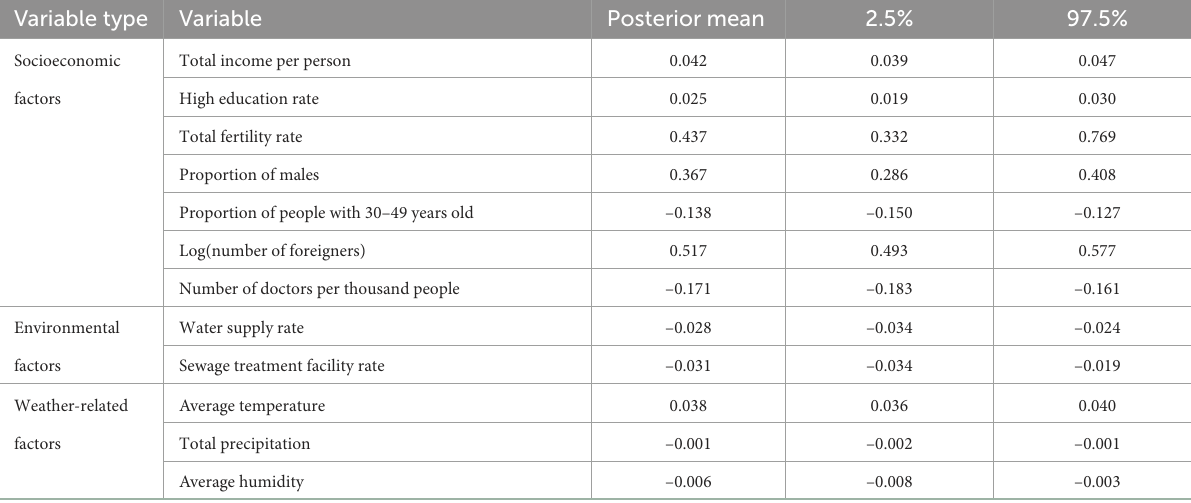
TABLE 5 Parameter estimates from the proposed